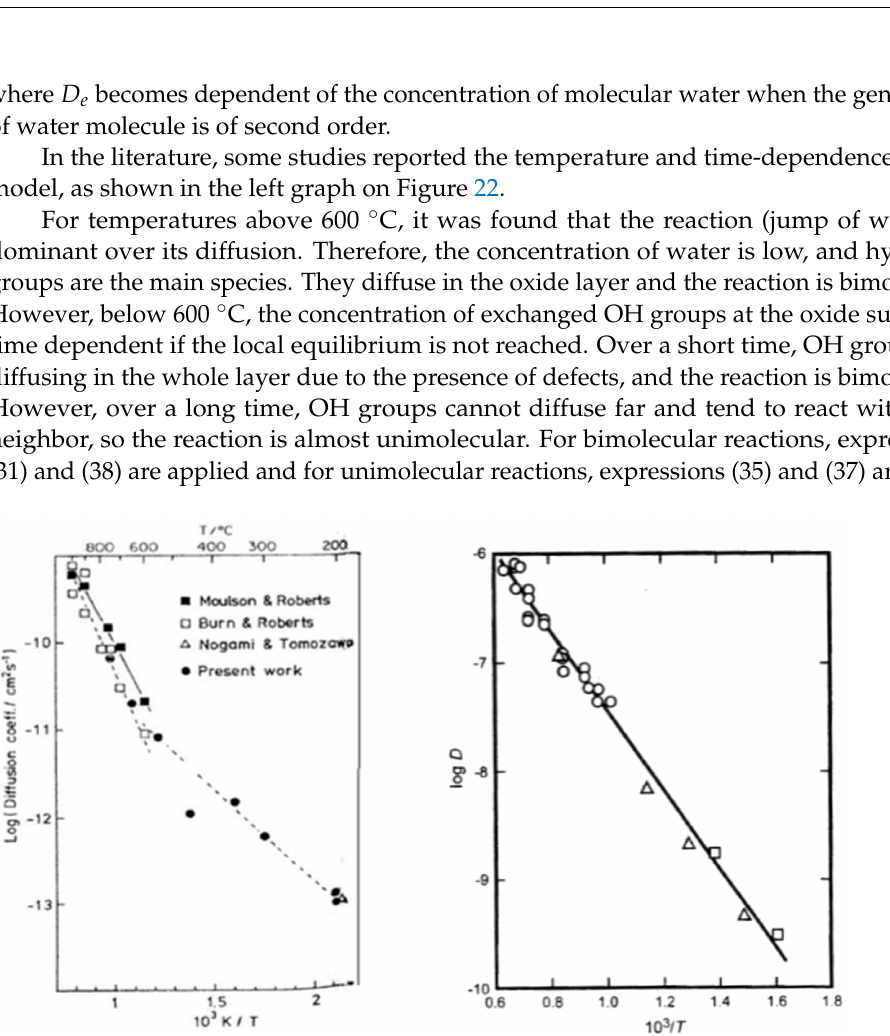
Figure 22. ( Left ) Arrhenius plot of the effective diffusion coefficient of water into silica glass. Reprinted with permission from Reference [85]. Copyright 1989 The American Ceramic Society/Wiley. ( Right ) Arrhenius plot of the diffusion coefficient of water into silica glass. Reprinted with permission from Reference [82]. Copyright 1999 Materials Research